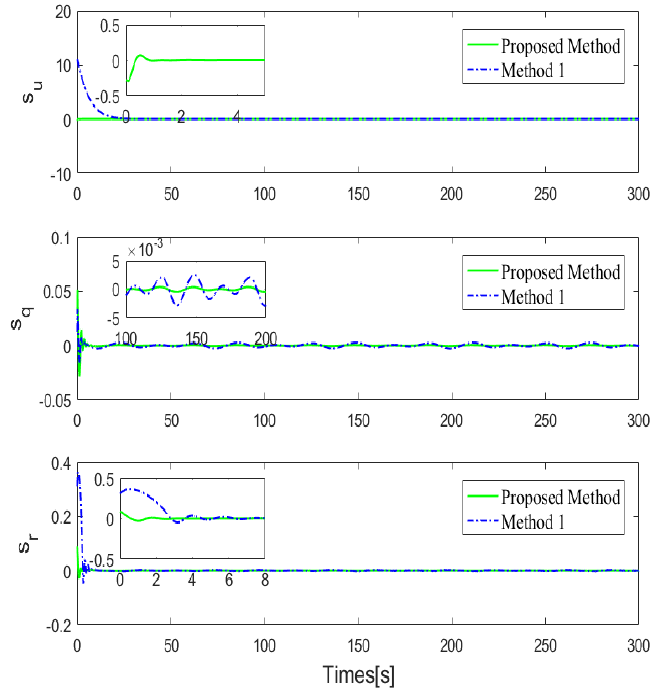
Figure 12. The comparison of sliding mode surface.